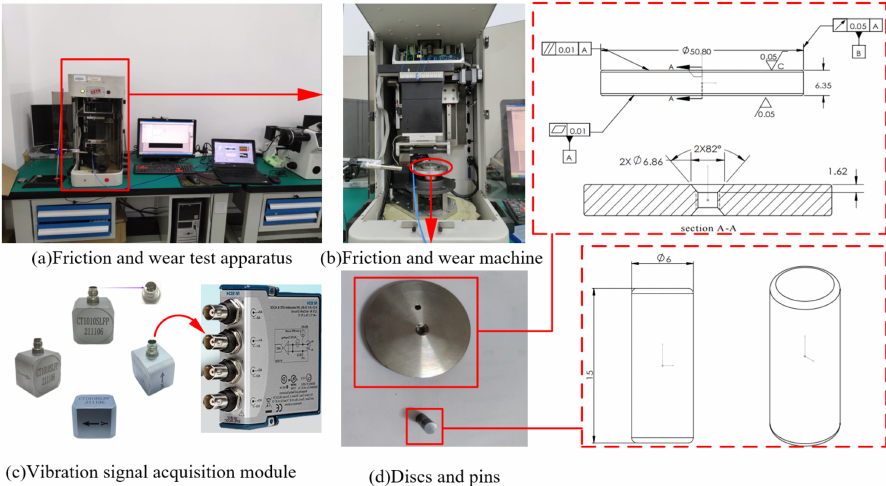
Figure 2. The friction and wear test device ( a – c ) and a schematic representation of the upper and lower samples ( d